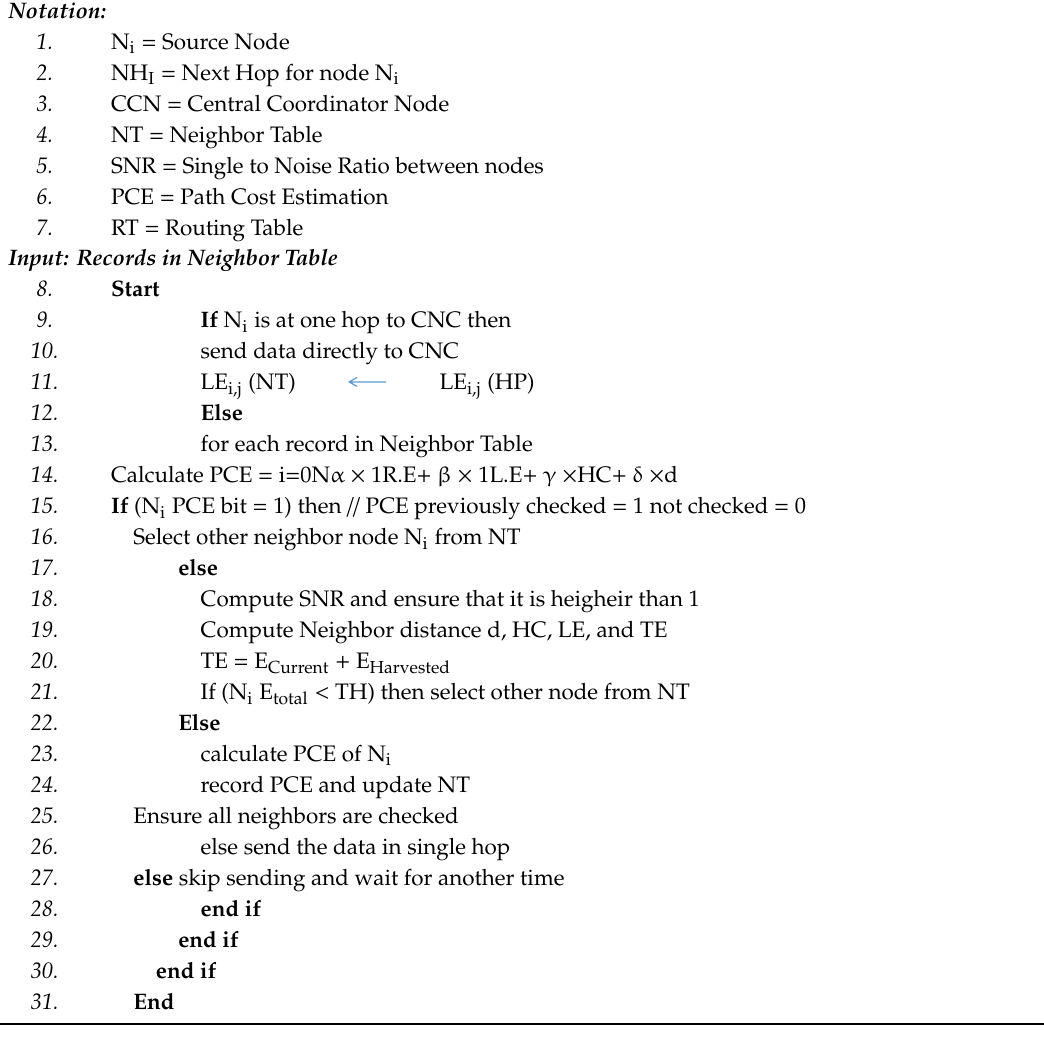
Algorithm 1: Data sensing and Topology discovery phase Notation: